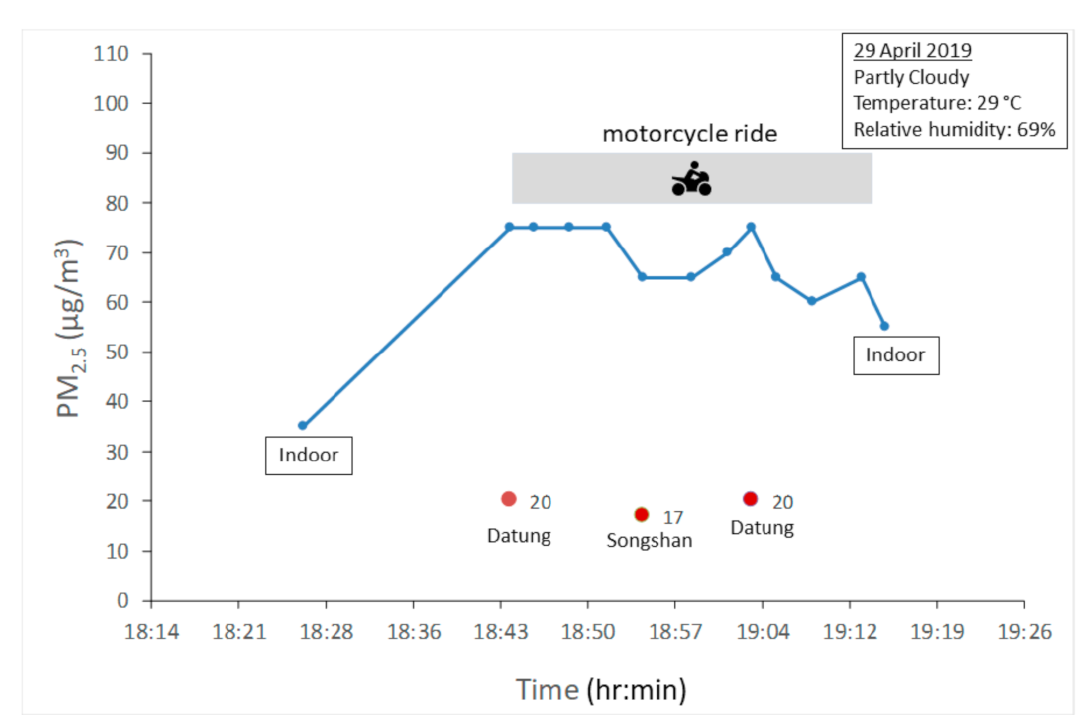
Figure 6. PM 2.5 concentrations during a bus ride.